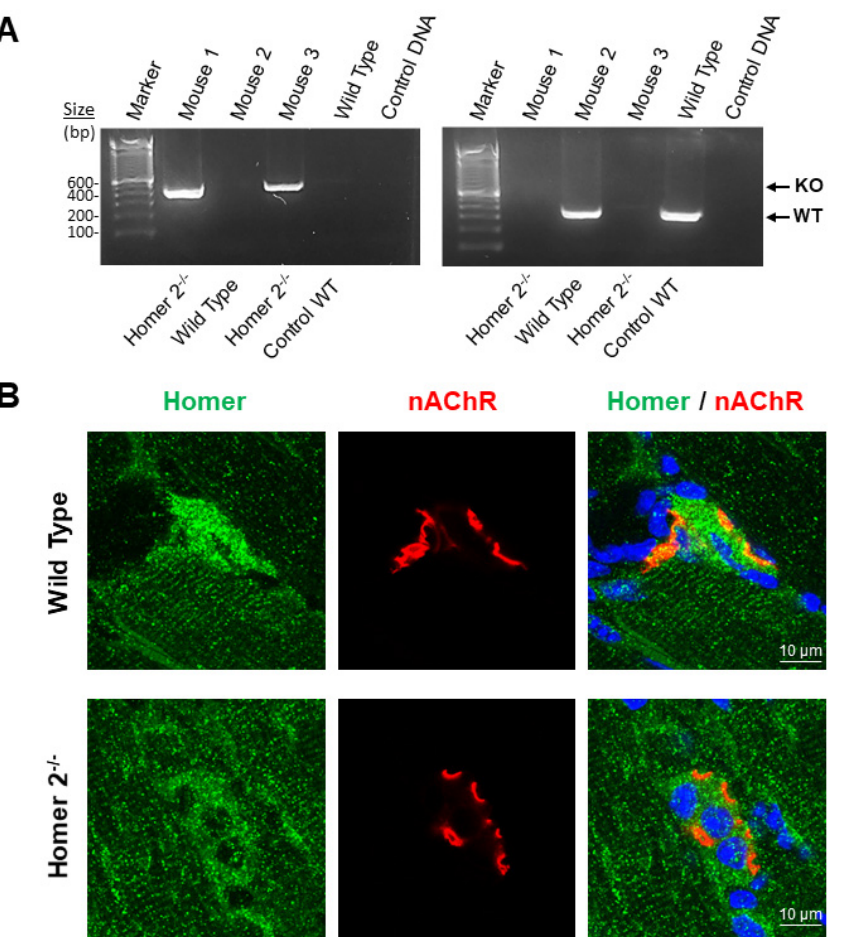
Figure 6. homer2 − / − genotyping and Homer confocal analysis in SOL muscle of WT and Homer2 − / − mice. ( A ). Agarose gel amplified cDNA fragment in WT and homer2 − / − male C57BL/N6 mice (19–20-week-old). As expected, a band of 321bp was detected in wild-type mice using a combination of primers 147 and 148 (WT), and a band around 432bp was detected in homer2 − / − mice using primers 147 and 149 (KO). ( B ) . Representative merged images of double staining experiments carried out with anti-Homer antibodies (green) and α -BTX (red) on SOL muscle longitudinal sections of WT and homer2 − / − male C57BL/N6 mice. Homer fluorescence immunoreactivity observed surrounding α -BTX-positive areas (NMJ postsynaptic microdomain) of WT mice was not detected in homer2 − / − mice. No differences were observed at the Z-disc/costamere level (cross-striated immunofluorescence pattern) between WT and homer2 − / − mice.